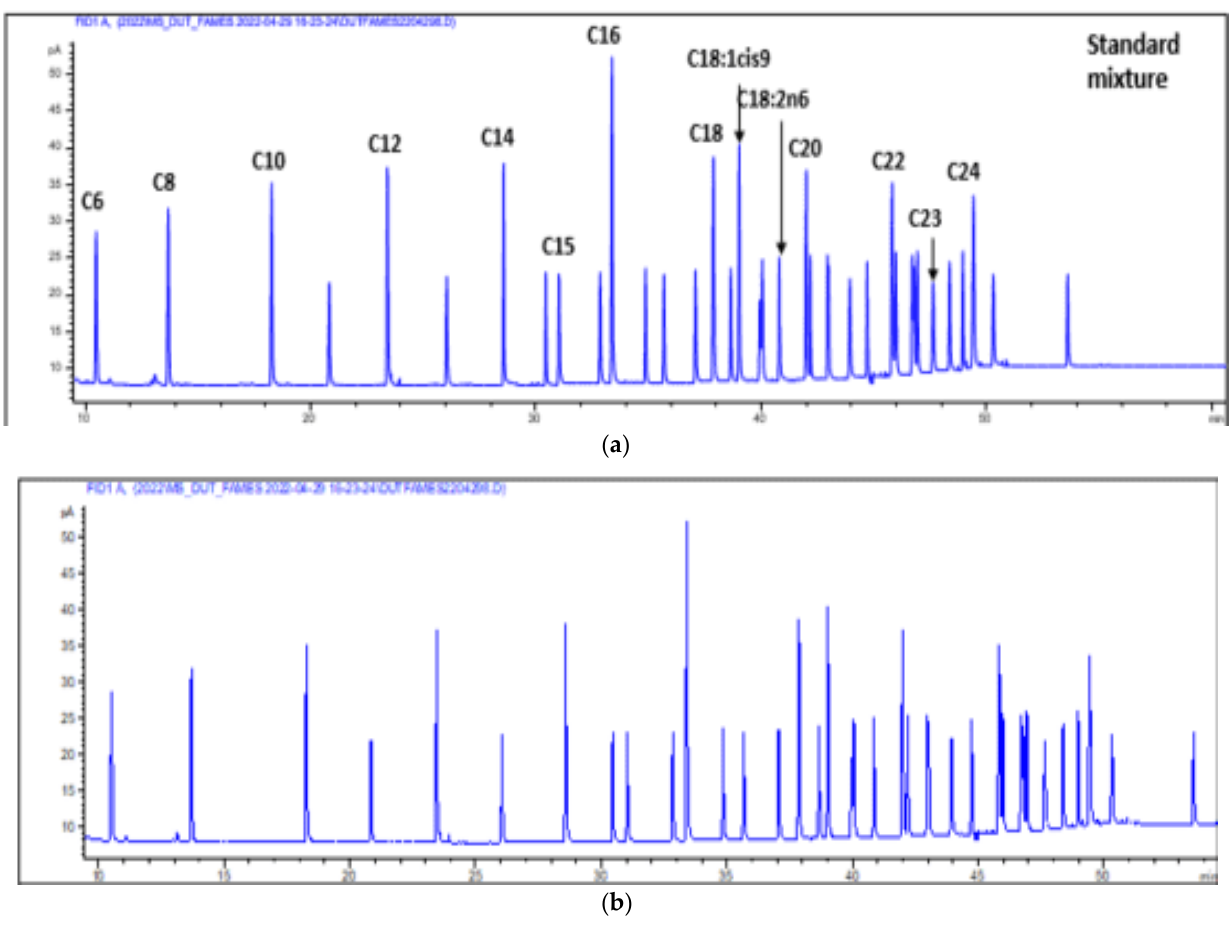
Figure 8. Representative total ion chromatograph (TIC) of ( a ) AGSUN 5102 CLP and ( b ) AGSUN 5106 CLP essential oils. 5106 CLP essential